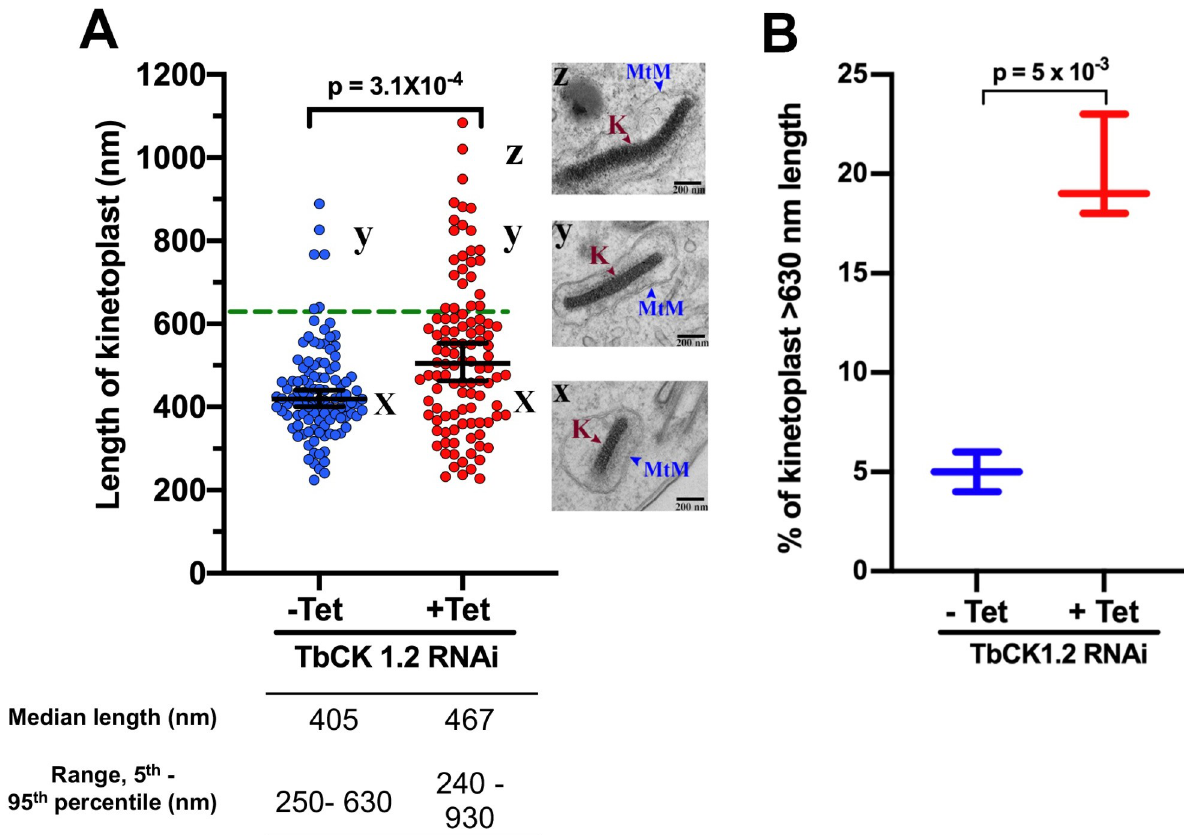
Fig 2. TbCK1.2 knockdown prevents scission of kDNA. Knockdown of TbCK1.2 was induced with tetracycline (1 µ g/mL for 24 h). (A) Scatter dot plot of kinetoplast length in uninduced (-Tet) and induced (+Tet) RNAi TbCK1.2 population. TEM images show kinetoplasts of different lengths (x � 400 nm, y � 800 and z � 1000 nm) in uninduced and induced TbCK1.2 RNAi cells. The 95 th percentile of kinetoplast length in control cells (uninduced) is indicated by horizontal dotted line (n = 216 (108, -Tet; 108, +Tet)). K, Kinetoplast; MtM, Mitochondrial membrane; TEM, Transmission Electron Microscopy. P -value was calculated using the Mann-Whitney U test. (B) Percentage of kinetoplasts longer than 630 nm in uninduced and induced populations of TbCK1.2 RNAi cells. Data was analyzed from three replicates, n = 632 (200, first replicate; 216, second and third replicates), P-value was calculated using an Unpaired Student’s